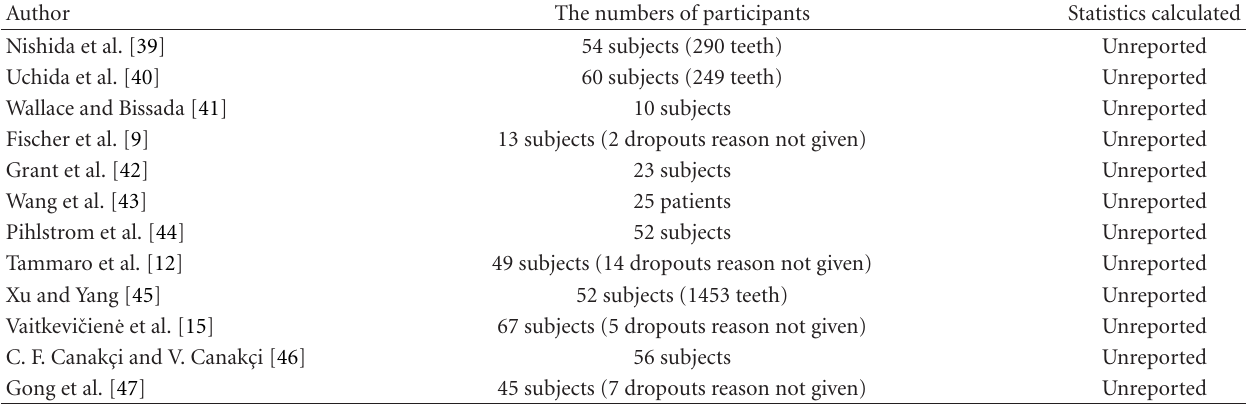
Table 3: Number of participants completing study and number of teeth assessed during the